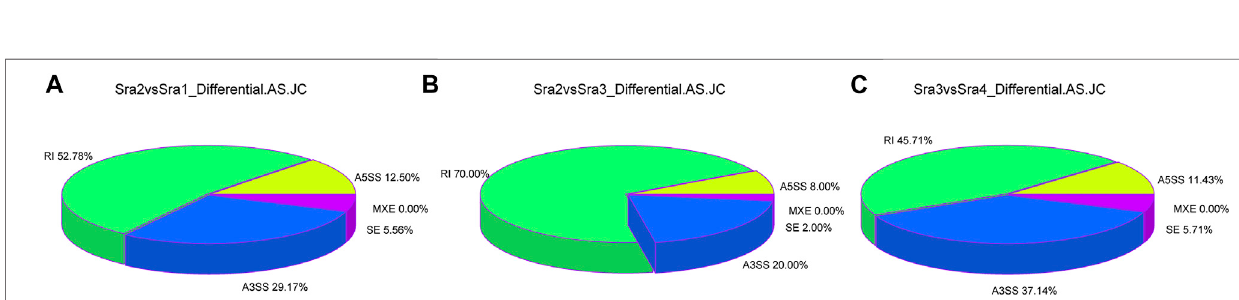
FIGURE 4 | KEGG pathway enrichment analysis of three PCGs. (A) Sra1 vs. Sra2 PCG; (B) Sra2 vs. Sra3 PCG; and (C) Sra3 vs. Sra4 PCG. The vertical axis represents thepathway, the horizontal axis represents rich factor, the size ofdots indicates the number of differentially expressed genes inthe pathway, and the colorof dots corresponds to different p value ranges.